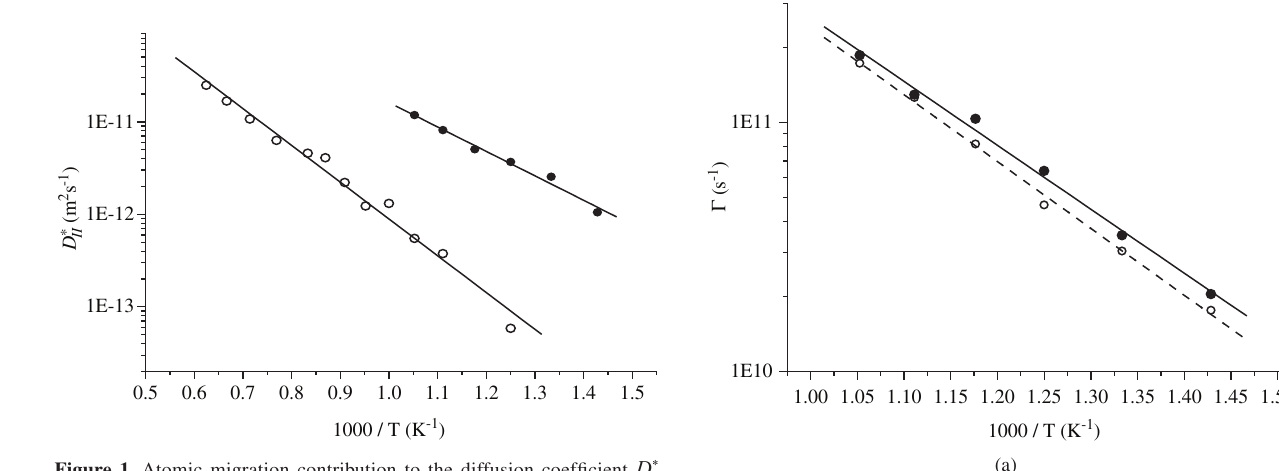
II obtained from Equation 9 for lattices with one vacancy: α -Zr (black circles)